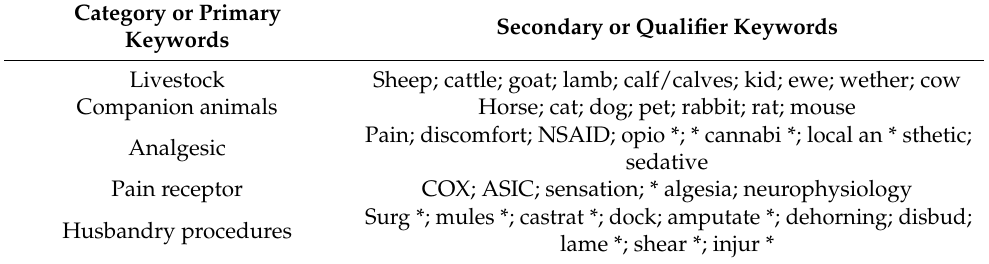
Table 2. Agreed Keywords for Literature Search.